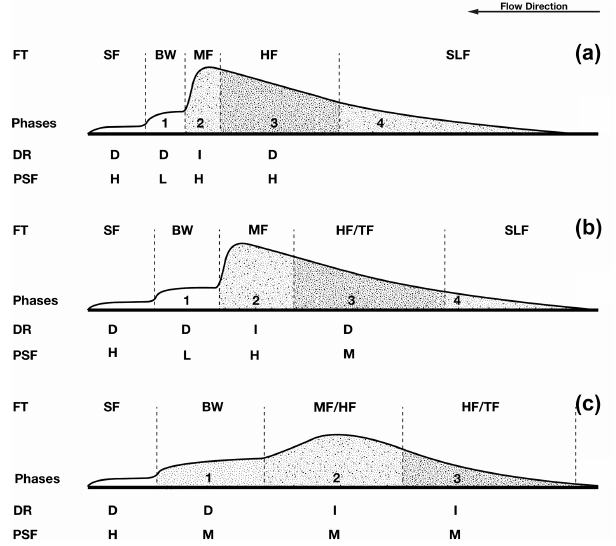
Figure 9. Conceptual models for the 18 March 2007 lahar at each of the three monitoring stations along the Whangaehu channel, depicting flow type and the estimated seismic properties at each flow phase. (a) RTMT 7.4km from source, (b) TRAN 28km from source, and (c) COLL 83km from source. Flow types (FTs) are as follows: streamflow (SF), bow wave streamflow (BW), mixed flow (MF), hyperconcentrated flow (HF), transitional flow (TF), and sediment-laden streamflow (SLF). Note that decreased (D), in- creased (I), high (H), low (L), and mixed (M) are notations for direc- tionality ratios and peak spectral frequency estimates. See Table S1 for value ranges for each